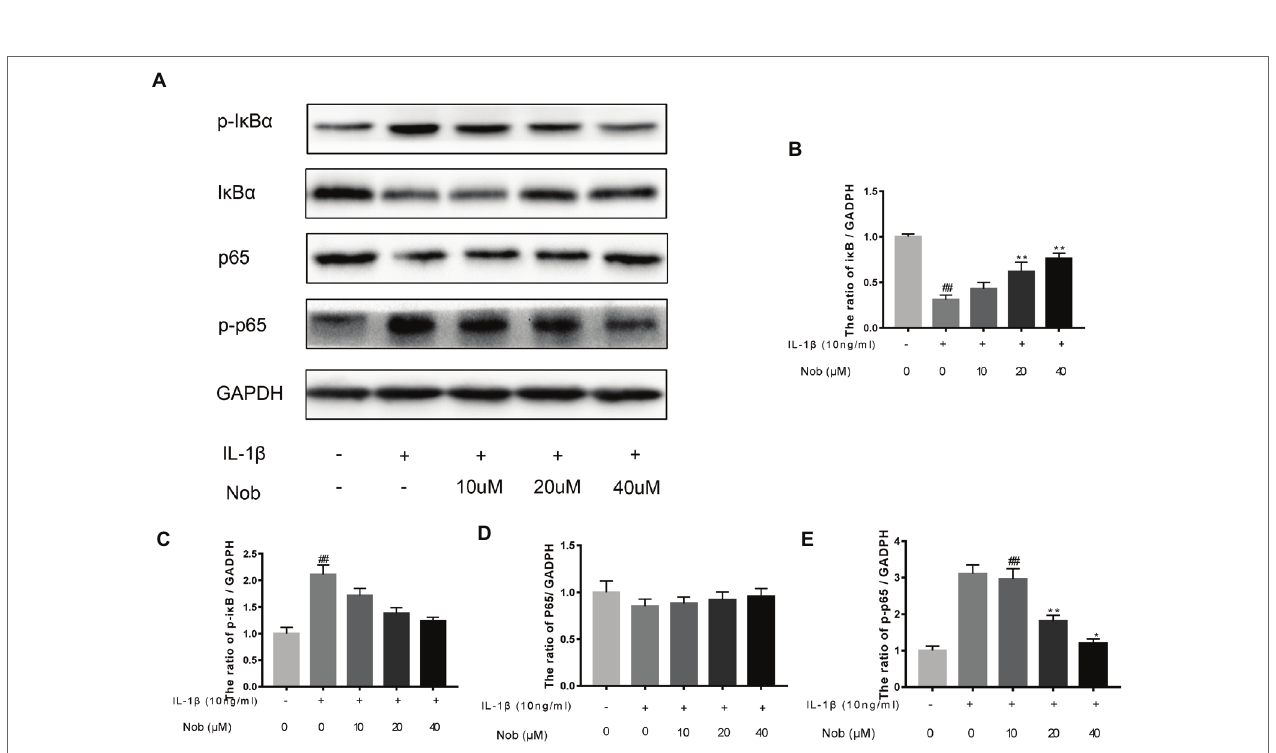
FIGURE 6 | Effects of nobiletin on IL-1 β -induced NF- κ B activation in mouse OA chondrocytes. Chondrocytes were pretreated for 24 h with various concentrations of nobiletin (10, 20, or 40 μM), followed by incubation for 24 h with or without IL-1 β (10 ng/ml). Protein expression levels of p65, p-p65, I κ B, and p-I κ B were determined by Western blot and quantification analysis (A–E) . Values represent mean ± SD of three independent experiments. ## p < 0.05, compared with control group. * p < 0.05 and ** p < 0.01, compared with IL-1 β group.